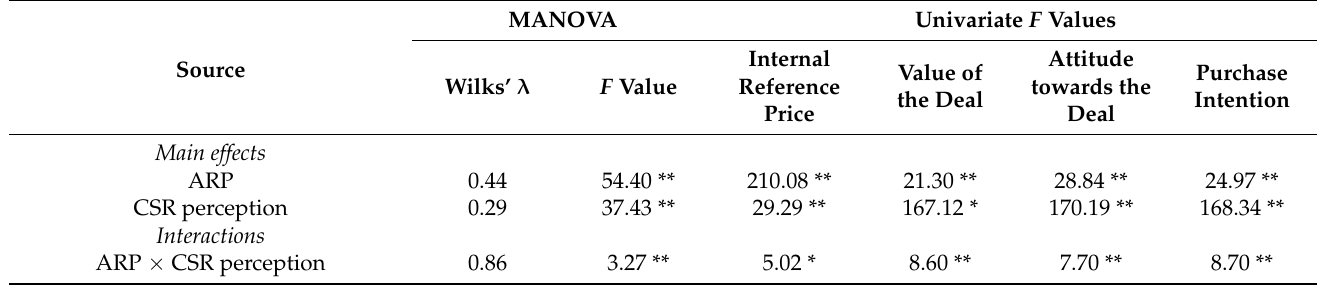
Table 3. Variance analysis of main and interaction effects of ARP and CSR contribution type.